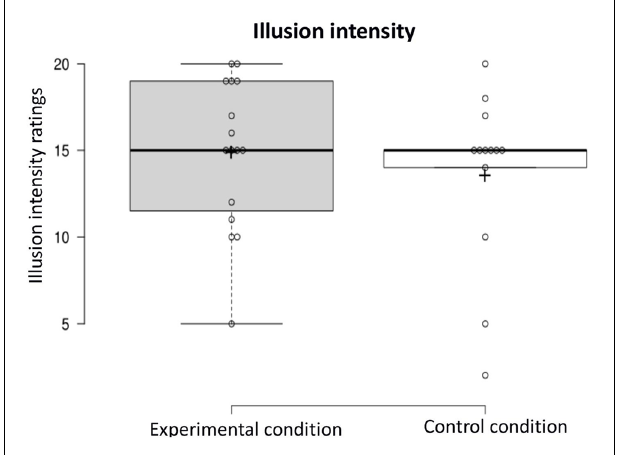
FIGURE 5 | Illusion intensity in the experimental and control